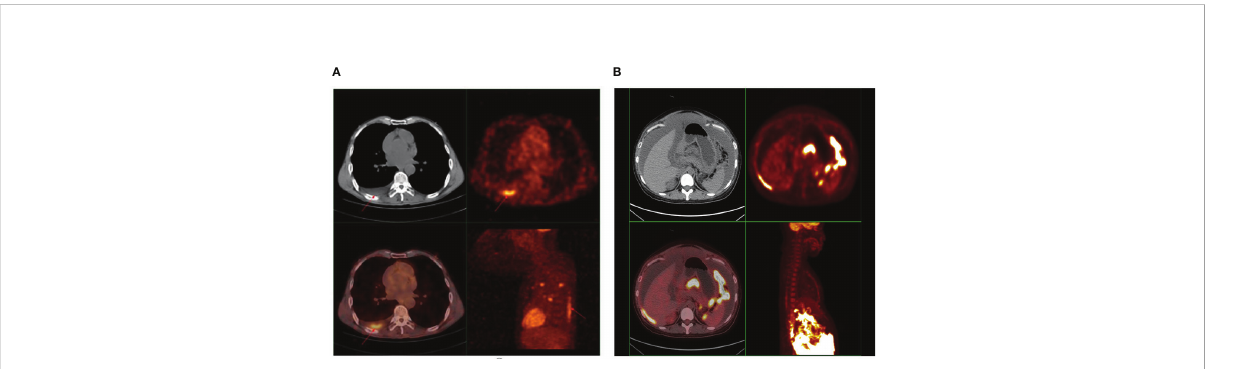
FIGURE 7 (A) A representative PET image showing 18 F-FDG uptake in pleural effusion of cancer patients. A 58-year-old male diagnosed with adenocarcinoma of the lung, underwent whole-body PET/CT examination. The image showed 18 F-FDG hypermetabolism in pleural effusion, and the SUV max was 6.9. (B) A representative PET image showing 18 F-FDG uptake in ascites of cancer patients. A 27-year-old female diagnosed with high-grade serous carcinoma of the ovary, underwent whole-body PET/CT examination. The image showed 18 F-FDG hypermetabolism in ascites, and the SUV max was